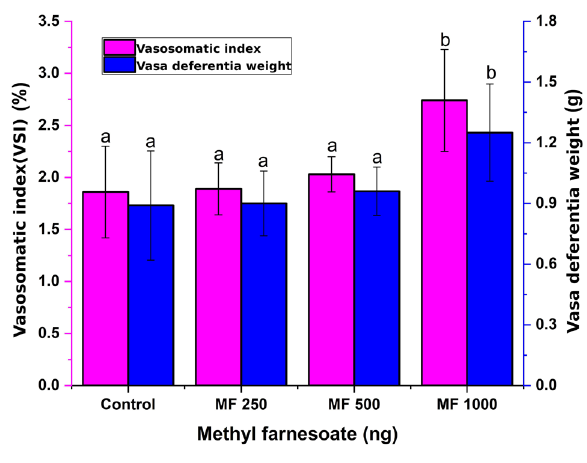
Figure 4. Effect of MF injection on vasa deferentia weight and VSI in male P. leptodactylus. Letters indicate significant difference groupings ( P < 0.05) (mean ± S.D; n=15).